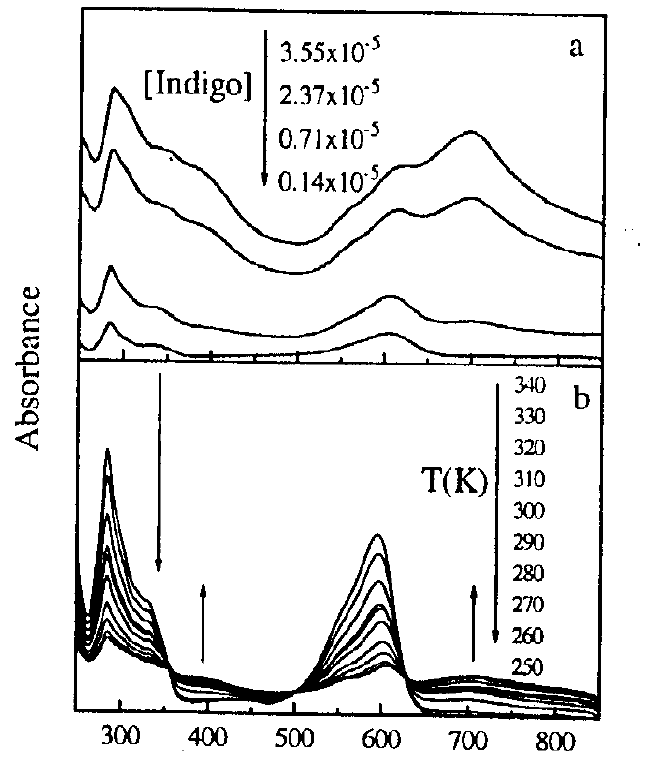
Figure 3. The variation of absorption spectrum of indigo in 1,2-dichloroethane with concentration (a) and temperature (b)